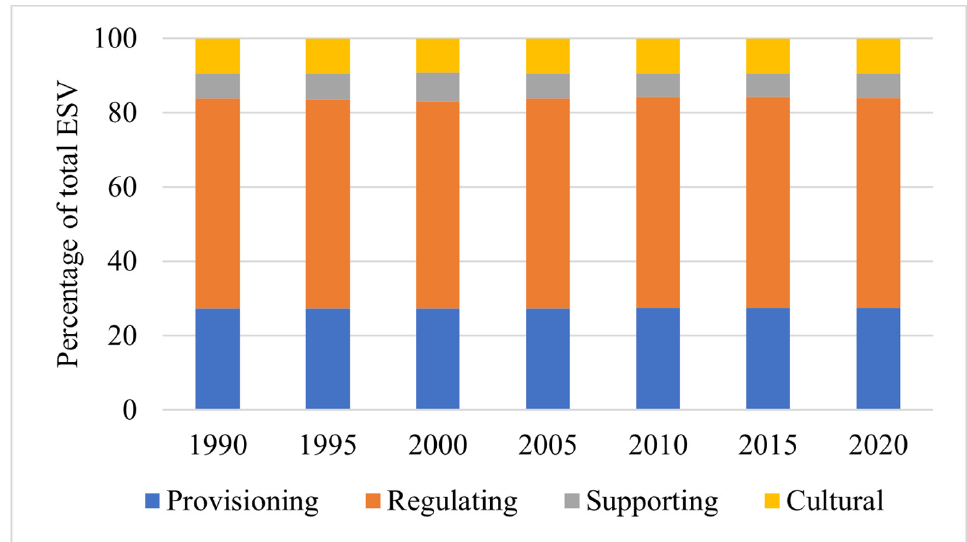
Figure 6. Contribution of individual ecosystem service to total ESV. According to Table 9, water supply, waste treatment, and disturbance regulation are three major contributors and share 22.90%, 25.60%, and 27.30% of total ESV, respectively, in 1990. Due to the large quantity of waterbodies and higher value of the coefficient, these three ecosystem functions generate higher ESV and contribute to the major portion of total ESV. Change in the value of individual ecosystem function were calculated during the period 1990–1995, 1995–2000, 2000–2005, 2005–2010, 2010–2015, 2015–2020 and are pre- sented in Table 10. Table 10. Change in the value (million USD) of individual ecosystem service function during the period 1990 to 2020. Ecosystem Service Function